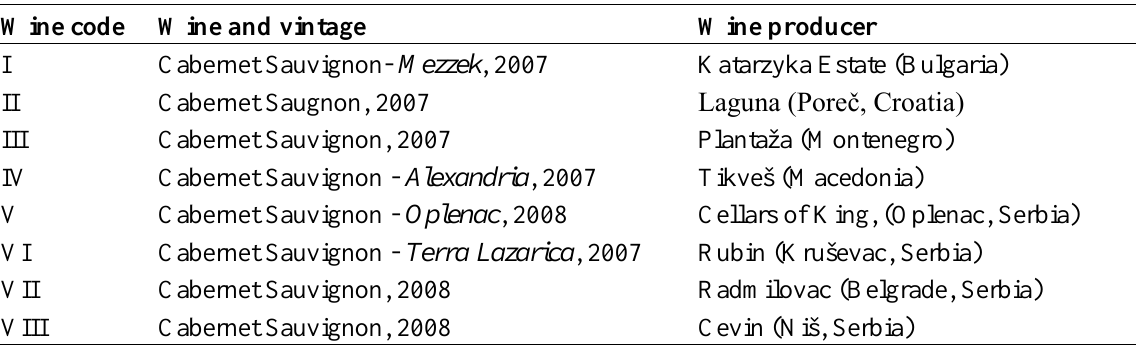
Table 1. The wine samples